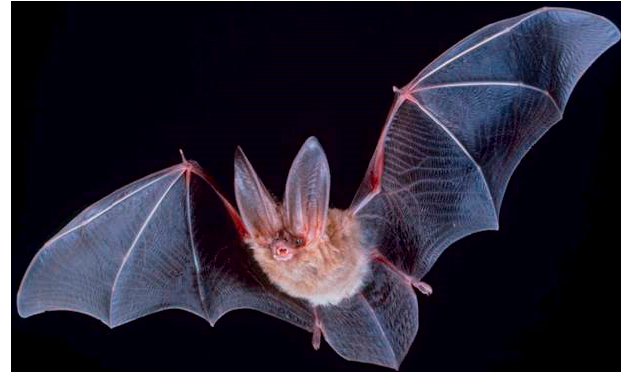
Figure 1. Bat pinnae of Townsend’s big-eared bat, Corynohinus townsendi [20].